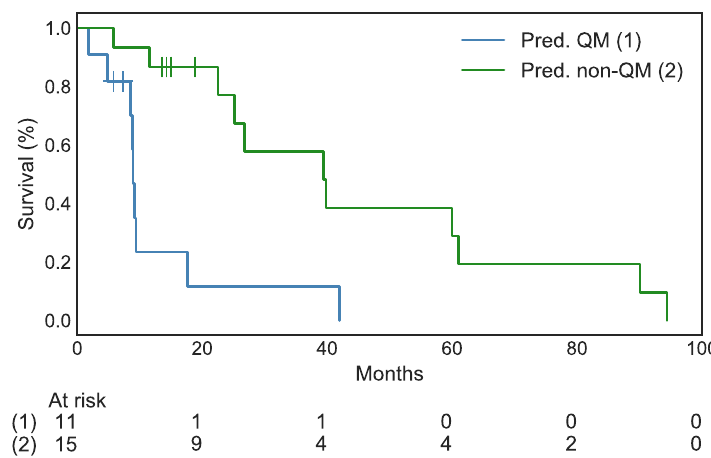
Figure 4. Highly significant separation of overall survival in the groups with predicted QM vs. non- QM tumors. HR: 4.33, 95% CI 1.14–13.32, log-rank test p < 0.0001. Vertical ticks indicate censorship.